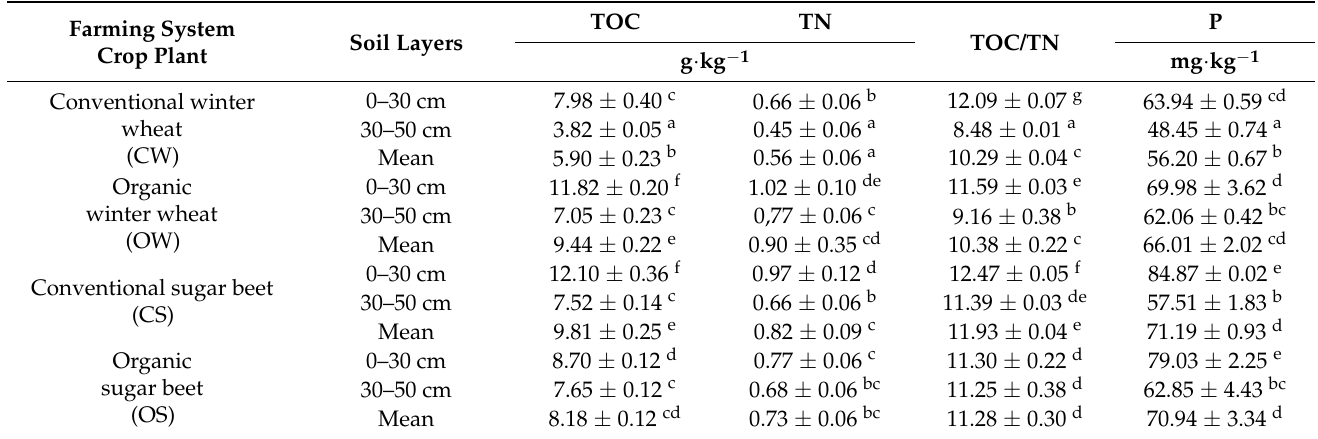
Table 6. Effect of the interaction of the experimental factors on the selected chemical properties of soil.